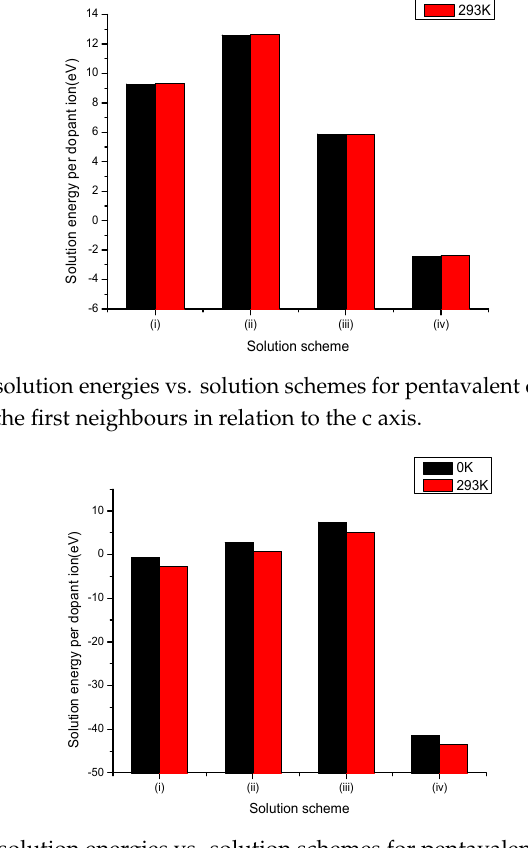
Figure 7. Bar chart of solution energies vs. solution schemes for pentavalent dopant (Mo 5 + ) at the Li and Nb sites, considering the first neighbours in relation to the c axis.